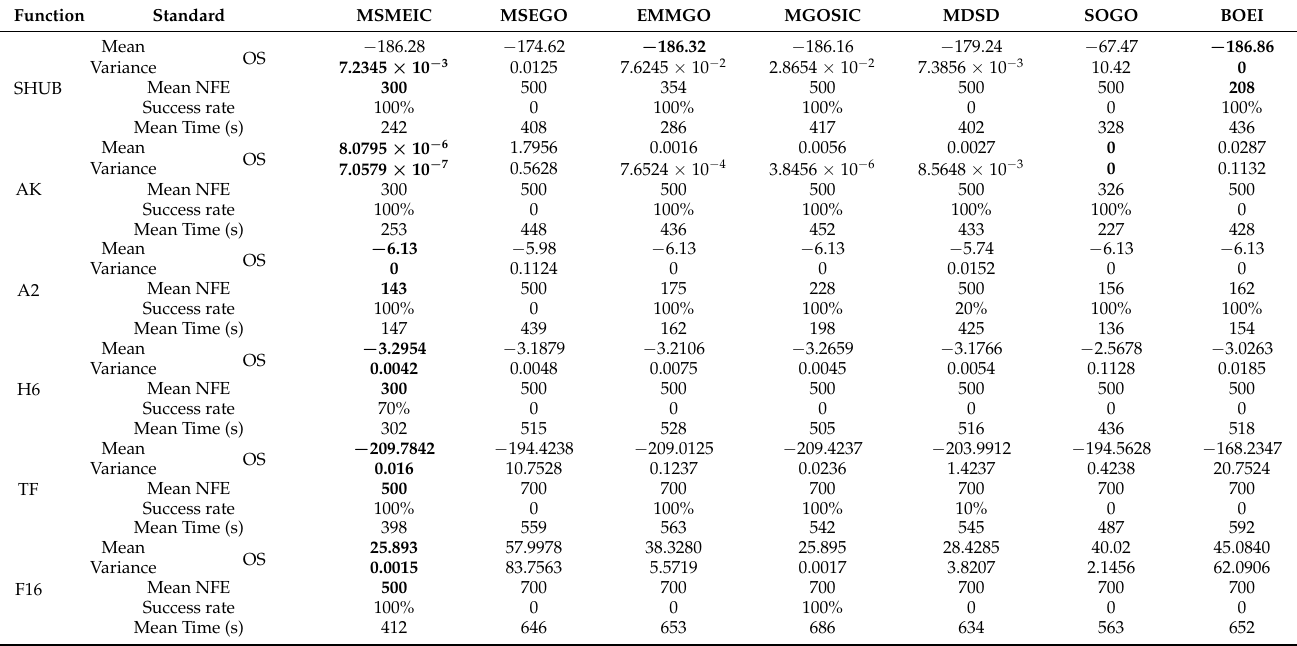
Table 2. Testing results of MSMEIC and other